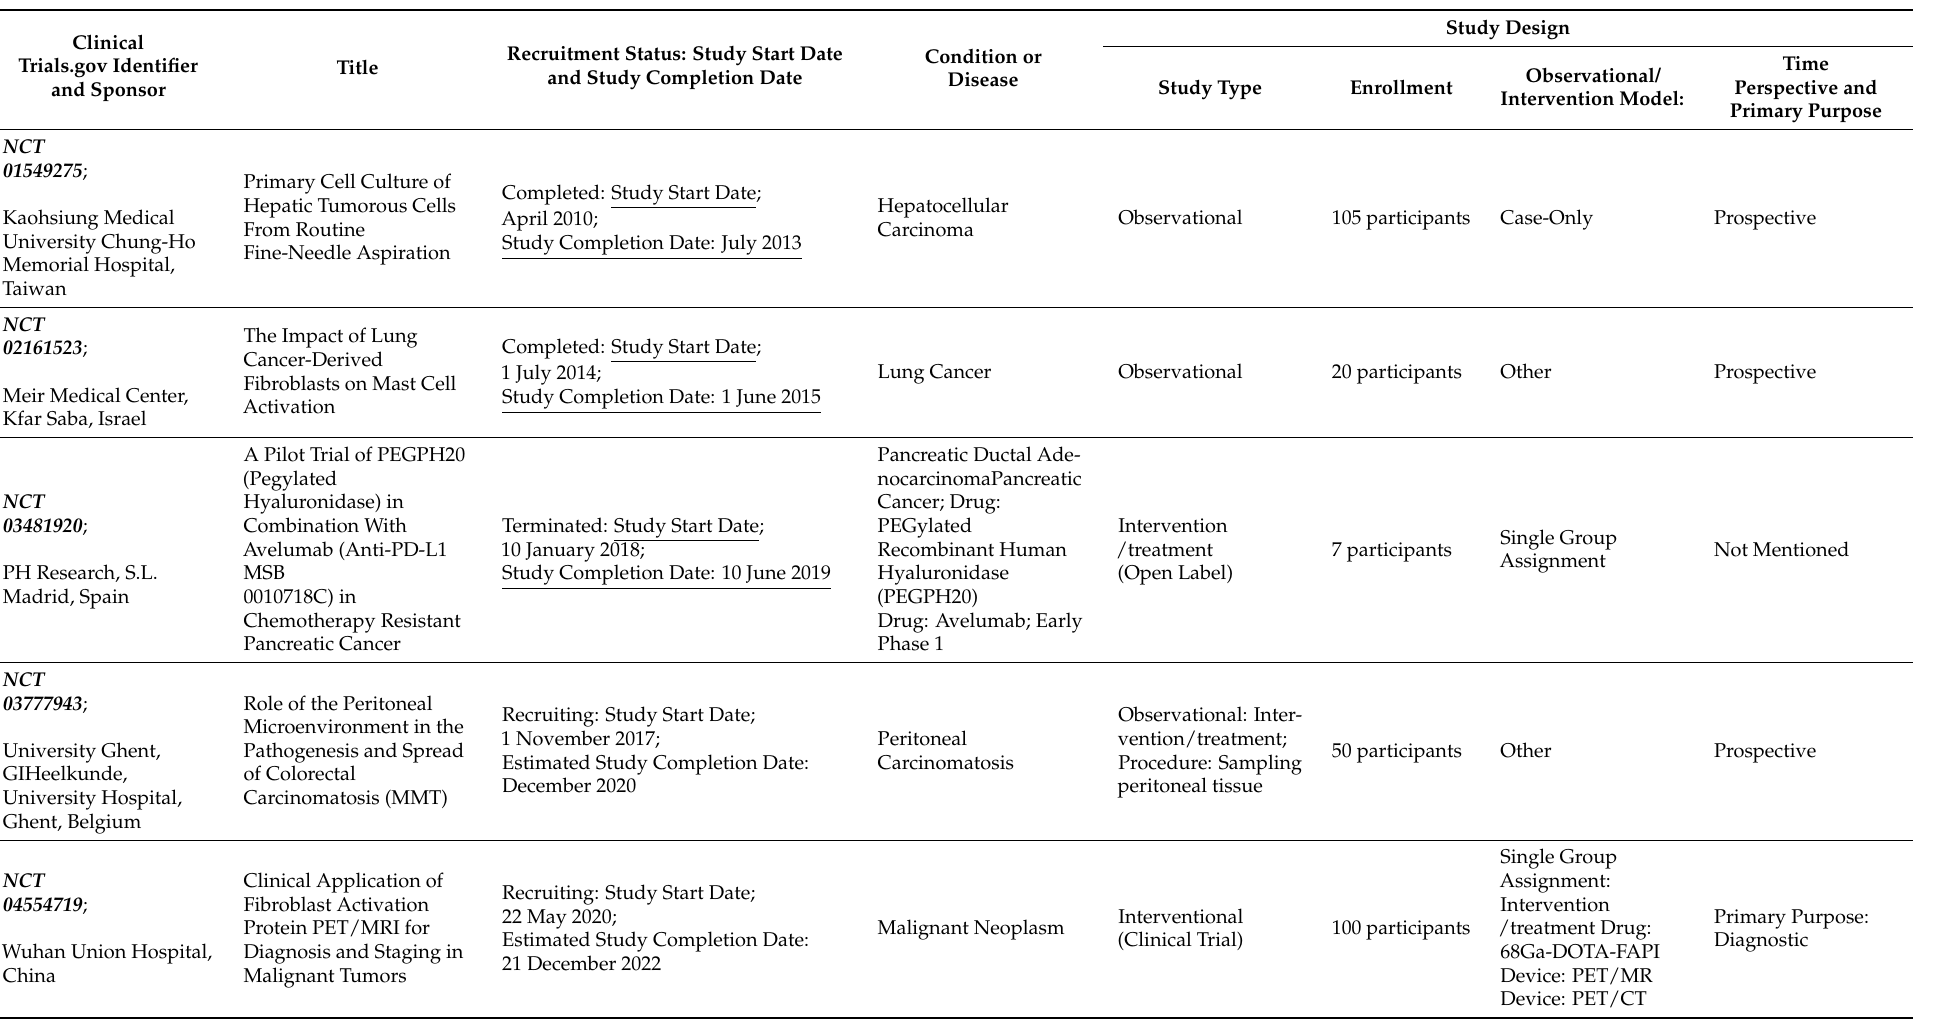
Table 1. Trials involving CAFs in cancers as posted in ClinicalTrials.gov (Updated on February 2022) are represented. The 17 trials include various organ cancers in solid tumors, including breast, colorectal, prostate, lung, pancreatic, hepatocellular, ovarian, and oral